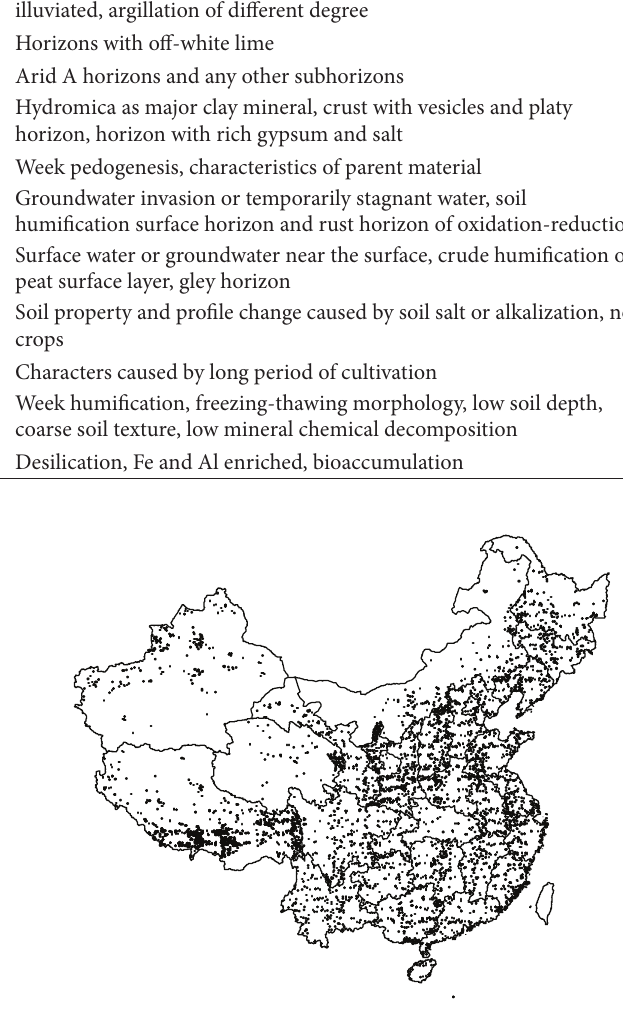
Figure 2: Location of soil profiles of China